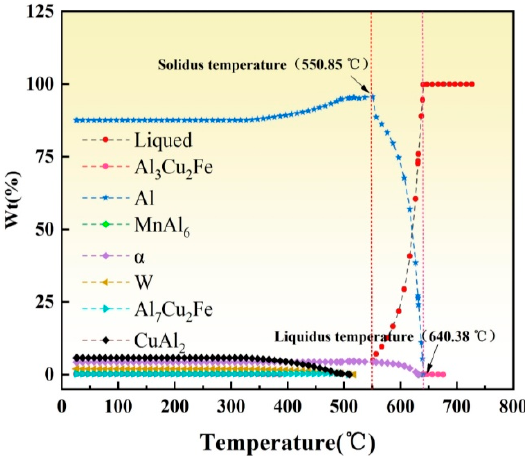
Figure 11. Evolution of precipitated phases in 2A14 Al-alloy with temperature.